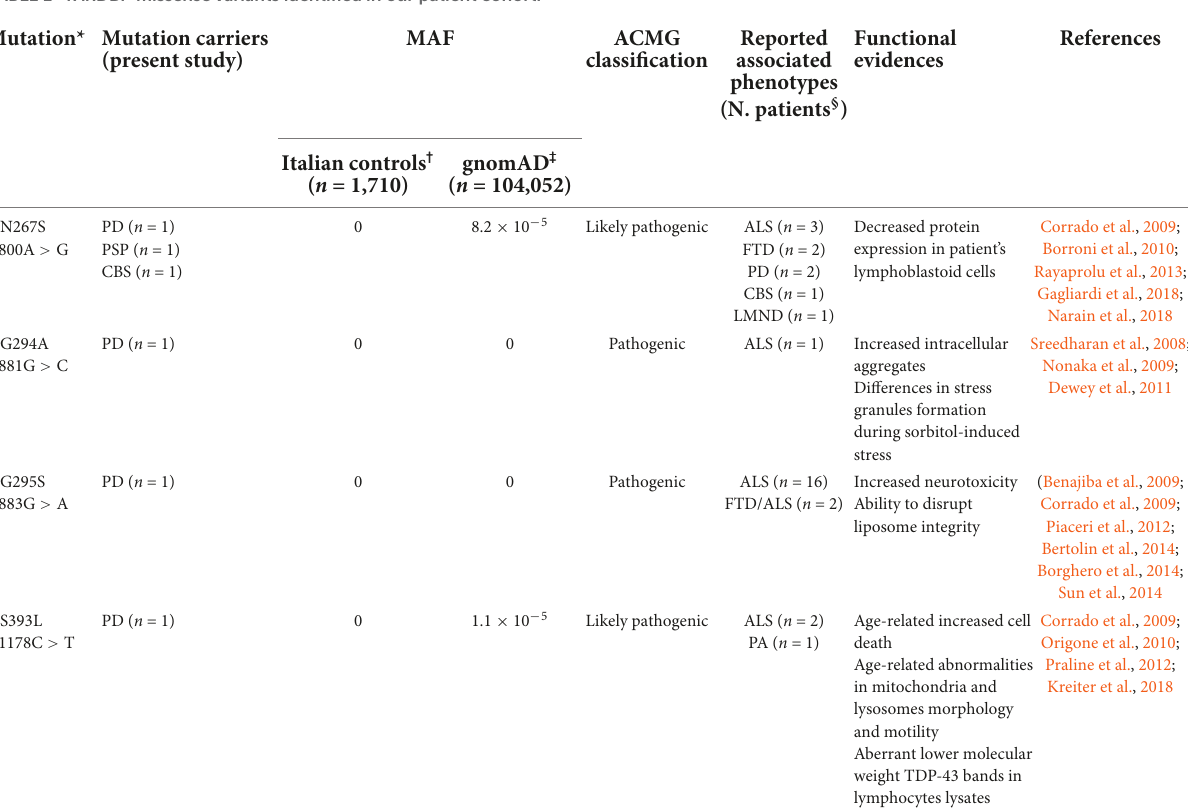
TABLE 1 TARDBP missense variants identified in our patient